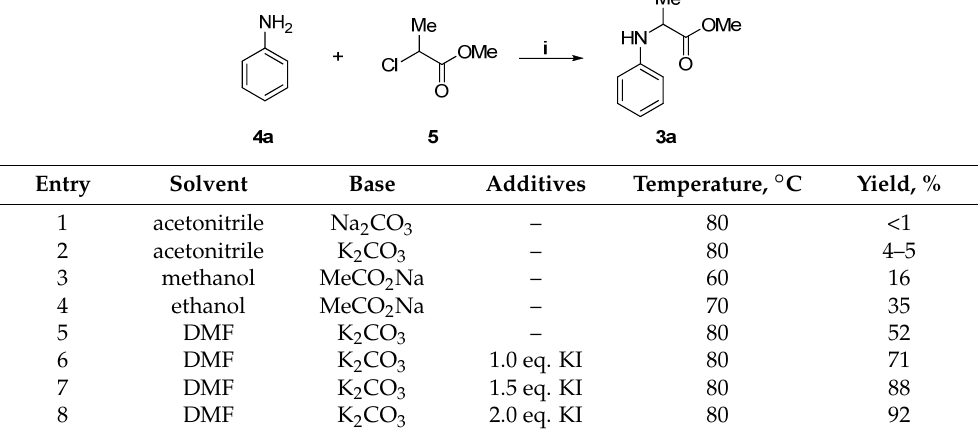
Table 2. Synthesis route of the target compounds 1a – l and 2a – l